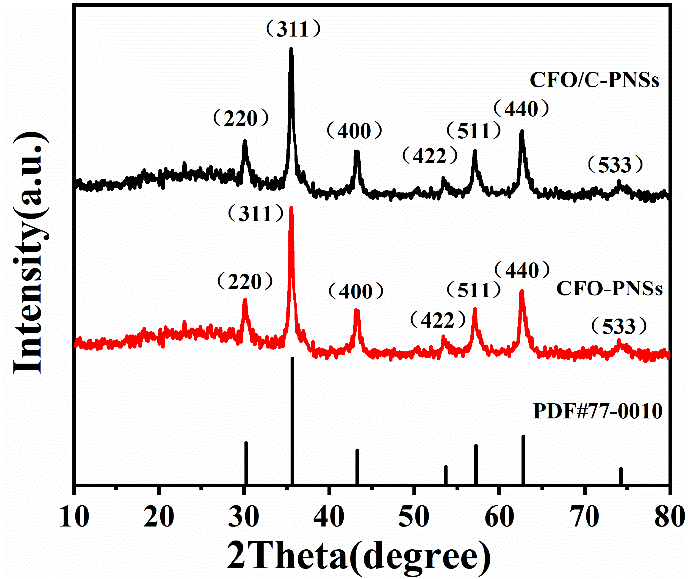
Figure 2. XRD spectra of CFO/C-PNS and CFO-PNS samples.